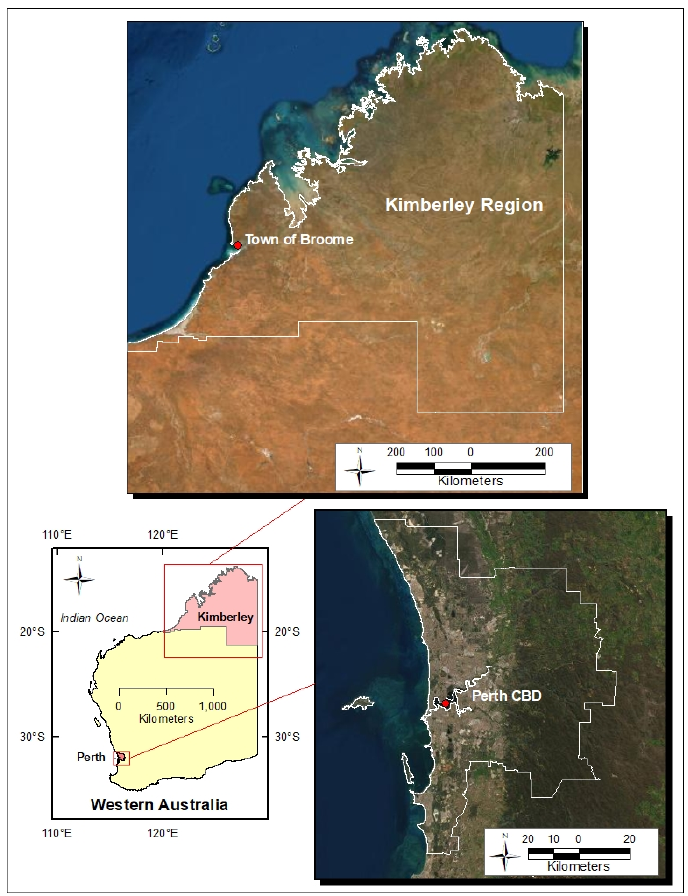
Figure 1. Location of Perth and the Kimberley within western Australia. (Image source: ESRI, Maxar, EarthStar Geographics and the GIS User Community ).